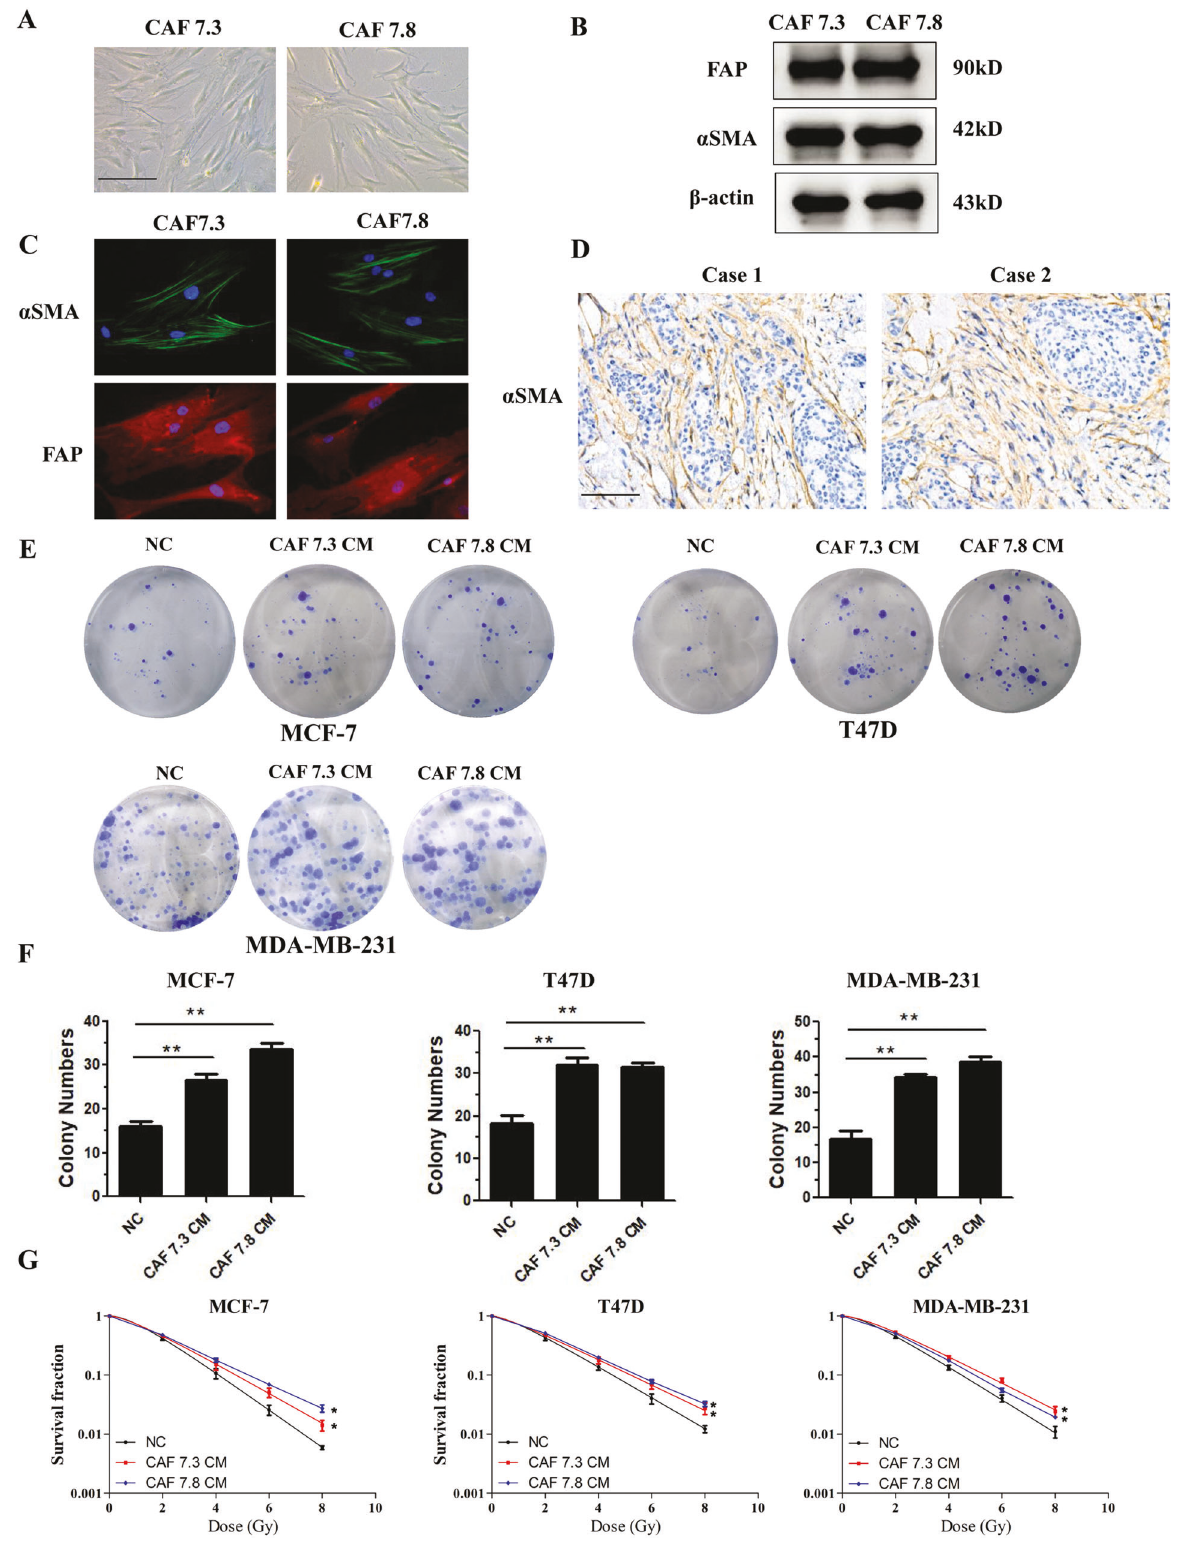
Fig. 1 CAFs confer growth and radioresistance of breast cancer cells. A Morphological features of primary fi broblasts isolated from fresh breast cancer tissue. Scale bars 50 μ m. B α SMA and FAP expression in primary fi broblasts was detected using western blotting. All the primary fi broblasts expressed high levels of α SMA and FAP, presenting characteristics of CAFs. C Immuno fl uorescence of α SMA and FAP in primary fi broblasts. D IHC labeling of α SMA in breast cancer tissue. Scale bars, 100 μ m. E , F Colony formation assay showing that breast cancer cells treated with CAF conditioned medium formed more colonies than the control cells. G Clonogenic survival assay showing that treatment with CAF conditioned medium increased the survival fraction of breast cancer cells. Results are shown as means ± SD, n = 3, * P < 0.05, ** P < 0.01.